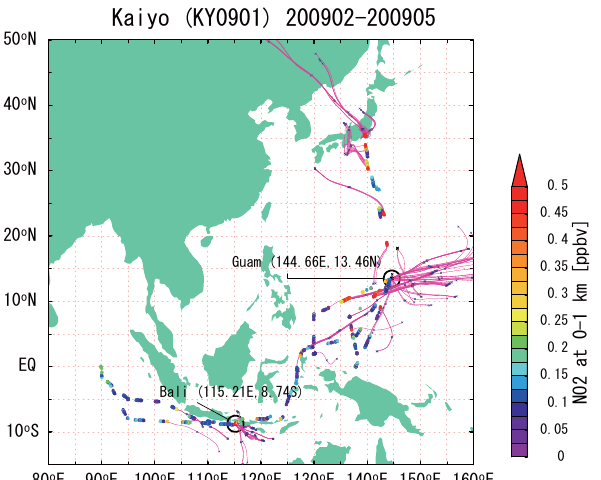
Fig. 11. Probability density function (PDF) of NO 2 concentrations at 0–1km observed by MAX-DOAS for concentrations of < 1ppbv. The distribution has been normalized so that the integrated proba- bility is equal to